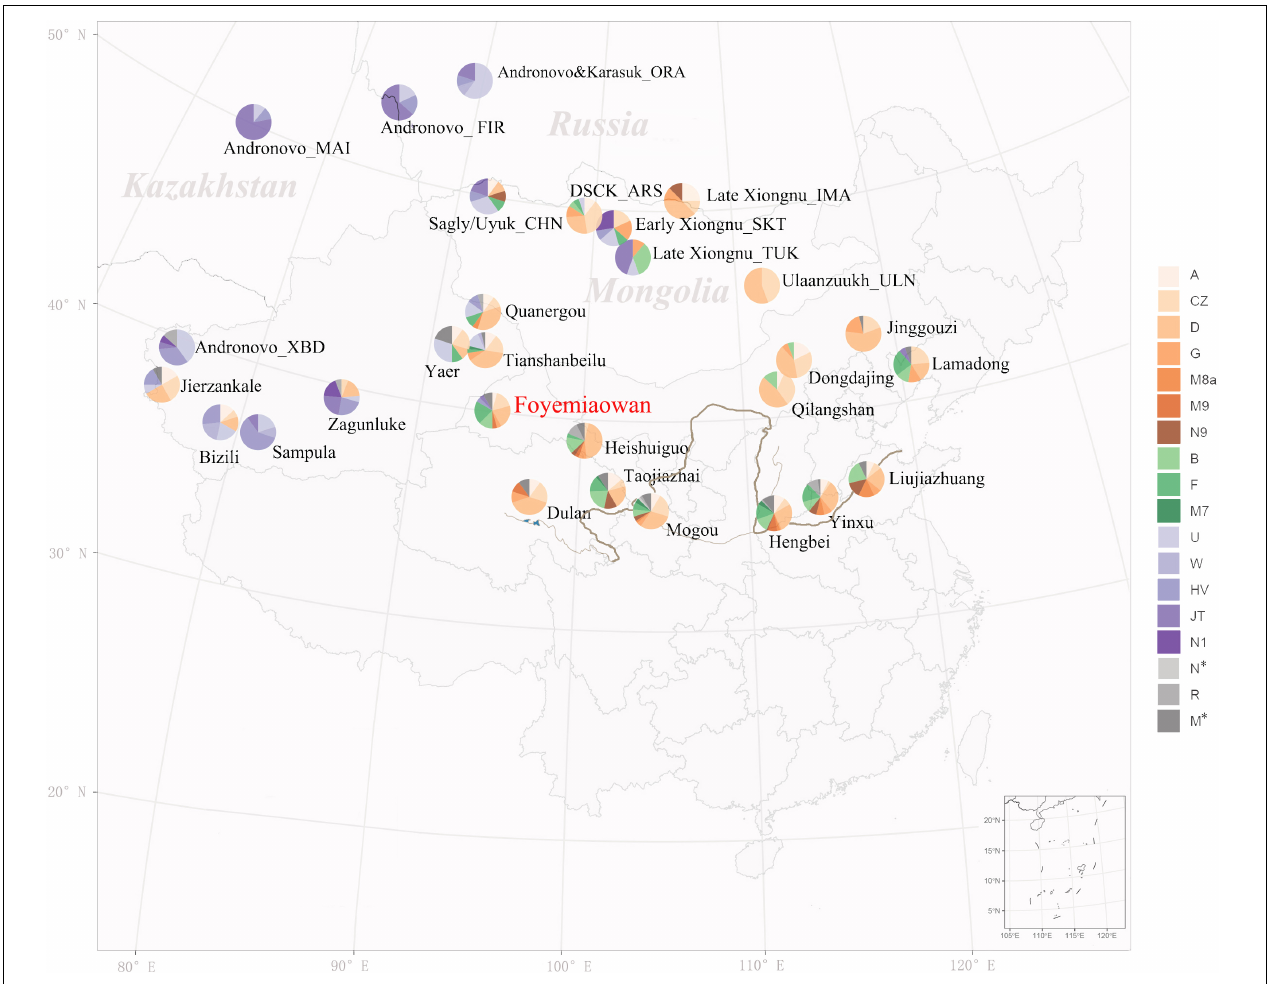
FIGURE 4 | Pie charts of the distribution of mtDNA macro-haplogroups in Foyemiaowan and surrounding populations from 2000BCE to